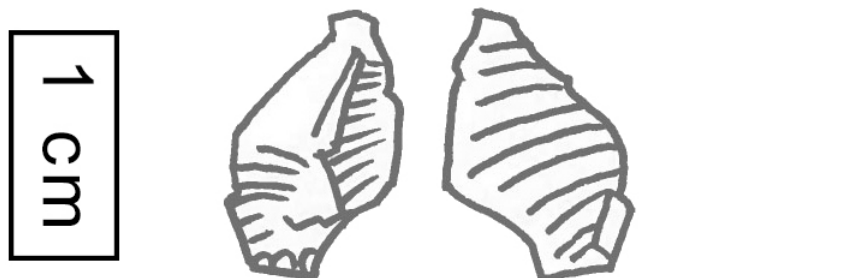
Figure 23. MP38 a bulb reduction flake (13x9x3 mm) (drawing by the author).